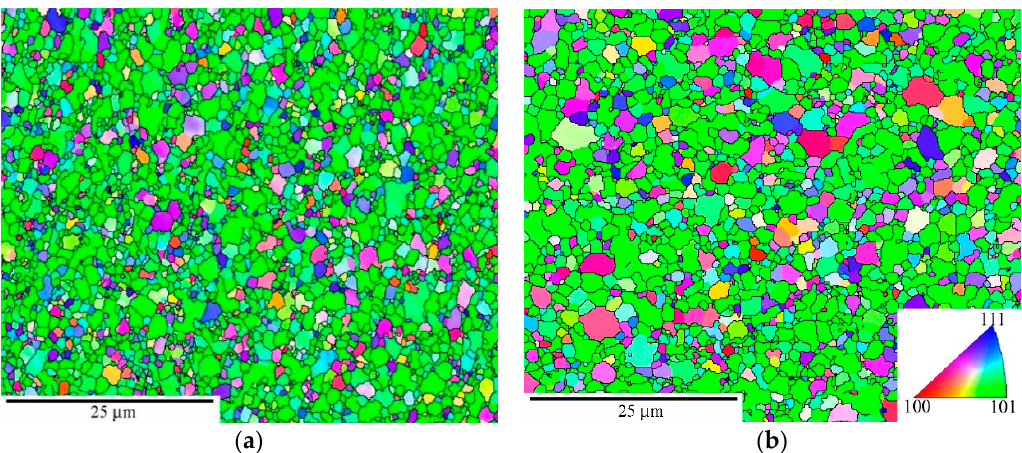
~0.03–0.05 (fine grain), ( b ) ε loc